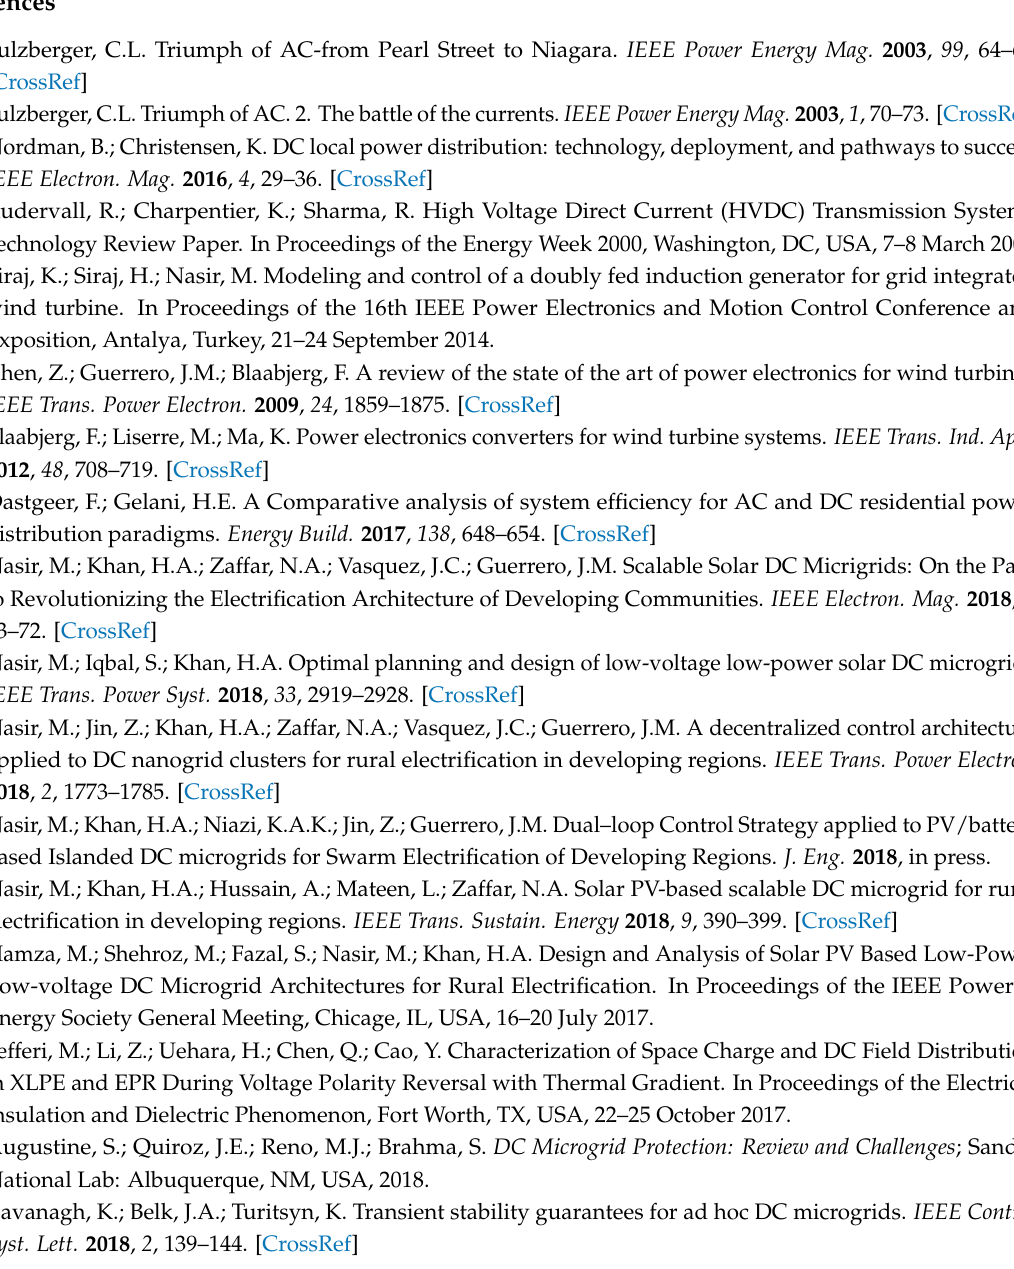
Figure A3. Solar insolation curve [38].